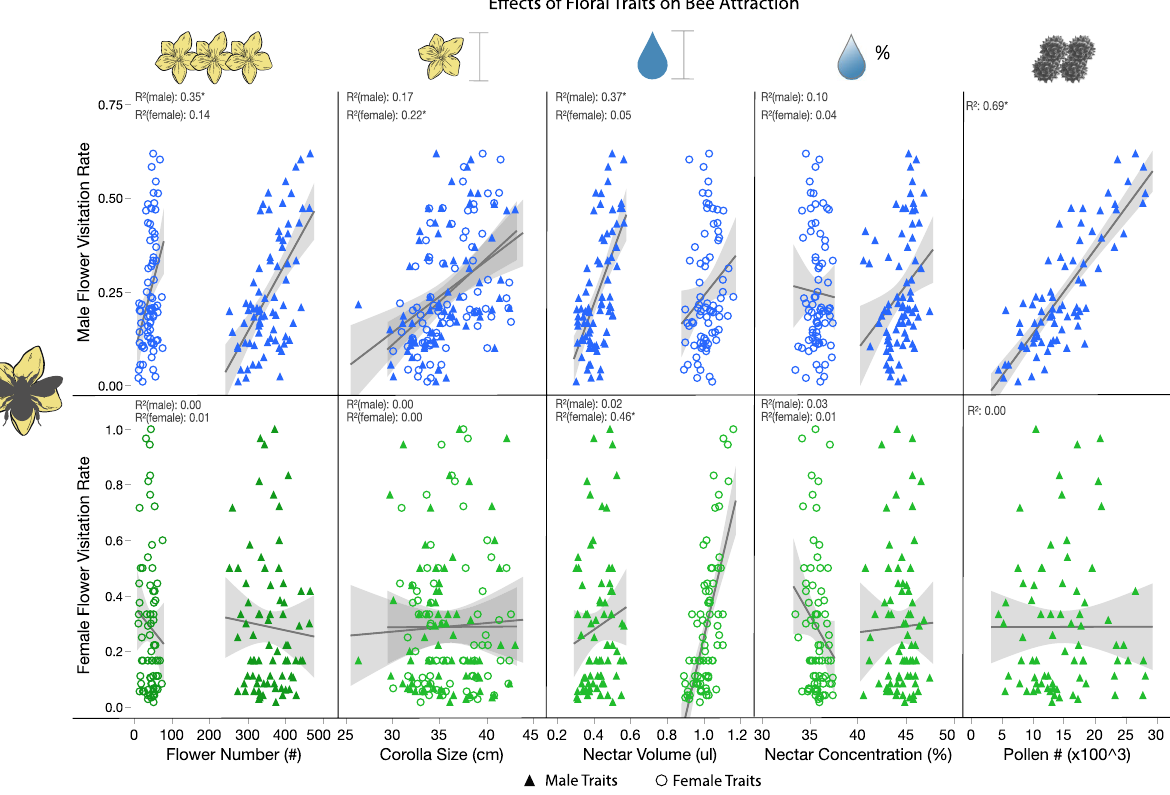
Figure 3. The effects of floral traits on bee visitation rates (Supplementary Table S4). The top and bottom rows represent male flower and female flower visitation rates respectively. Each marker is shaped by whether the predictor is a female flower trait (circle) or male flower trait (triangle). Note that male visitation rates are positively associated with many male flower traits, including flower number, size, volume, and pollen number. Yet, female flower visitation rate is only associated with female nectar